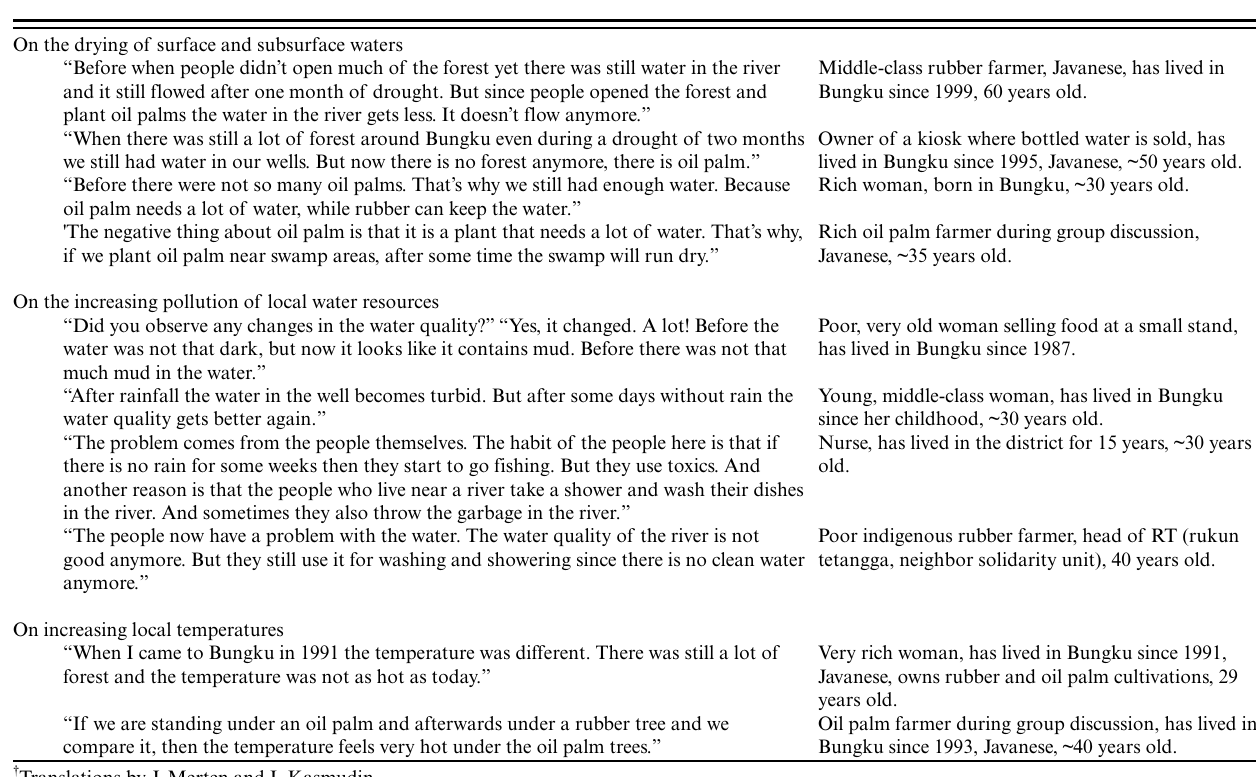
Table 1 . Representative quotes from the interviews and group discussions † of the social case study. Interviews were conducted in the village of Bungku, Jambi, from May to July